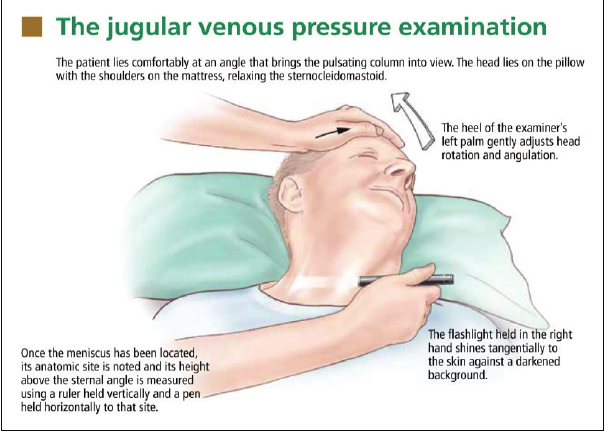
FIGURE 1: The jugular venous pressure measurement.